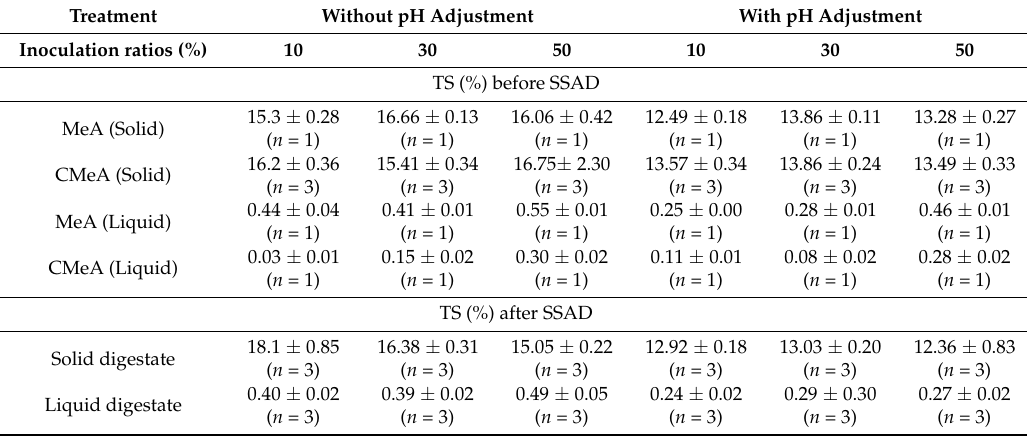
Table 2. Comparison of TS of MeA mixture, dairy cattle manure/MeA mixture (CMeA), and digestate among treatments.